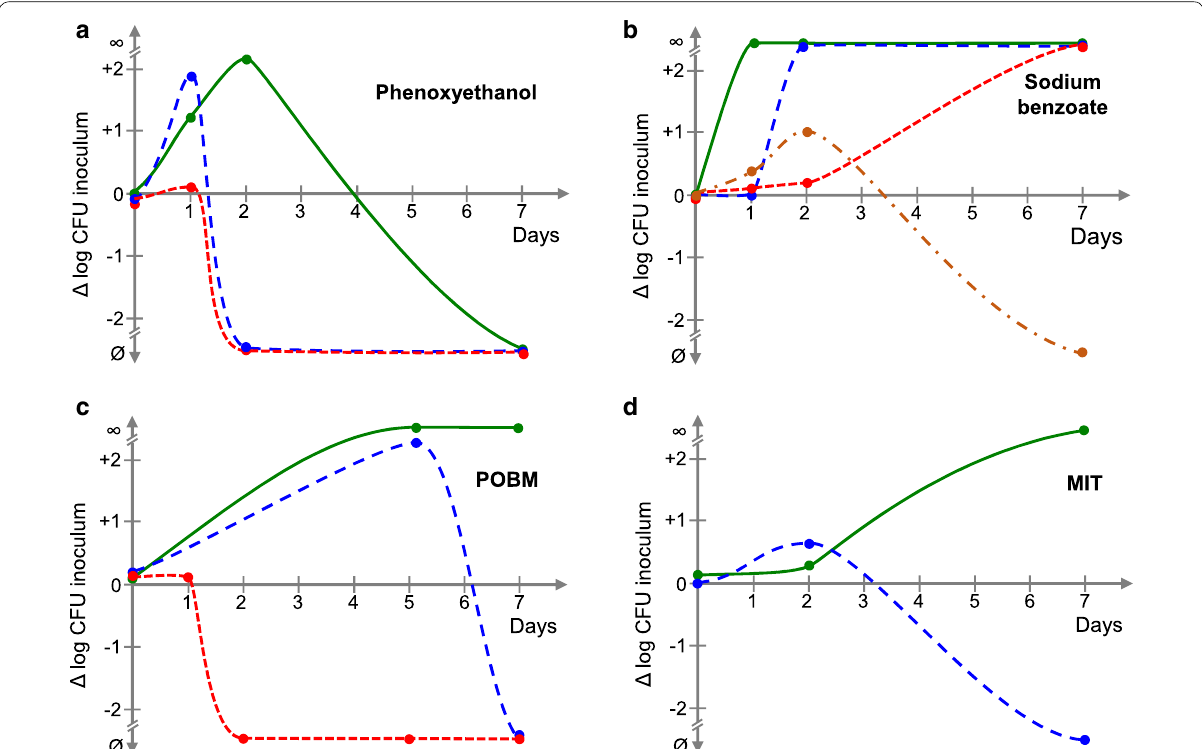
Fig. 3 Comparison of the bacteriostatic activities of media produced in the presence of common organic preservatives. The evolution of the contamination was measured over 7 days and was expressed as the logarithmic variation of the initial inoculum (Δlog CFU: colony‑forming unit). a Phenoxy ethanol 0.3% green lines , 0.32% blue dotted lines and 0.35 red dotted lines%. b Sodium benzoate 0.01% green lines, 0.03% blue dotted lines, 0.04% red dotted lines, and 0.05% orange dotted lines. c POBM (methyl paraben) 0.1% green lines, 0.12% blue dotted lines and 0.15% red dotted lines. d MIT (methyl isothizolinone) 0.001% green lines and blue dotted lines 0.002%. All experiments were performed in triplicate and completed with tests at higher and lower concentrations (not shown)